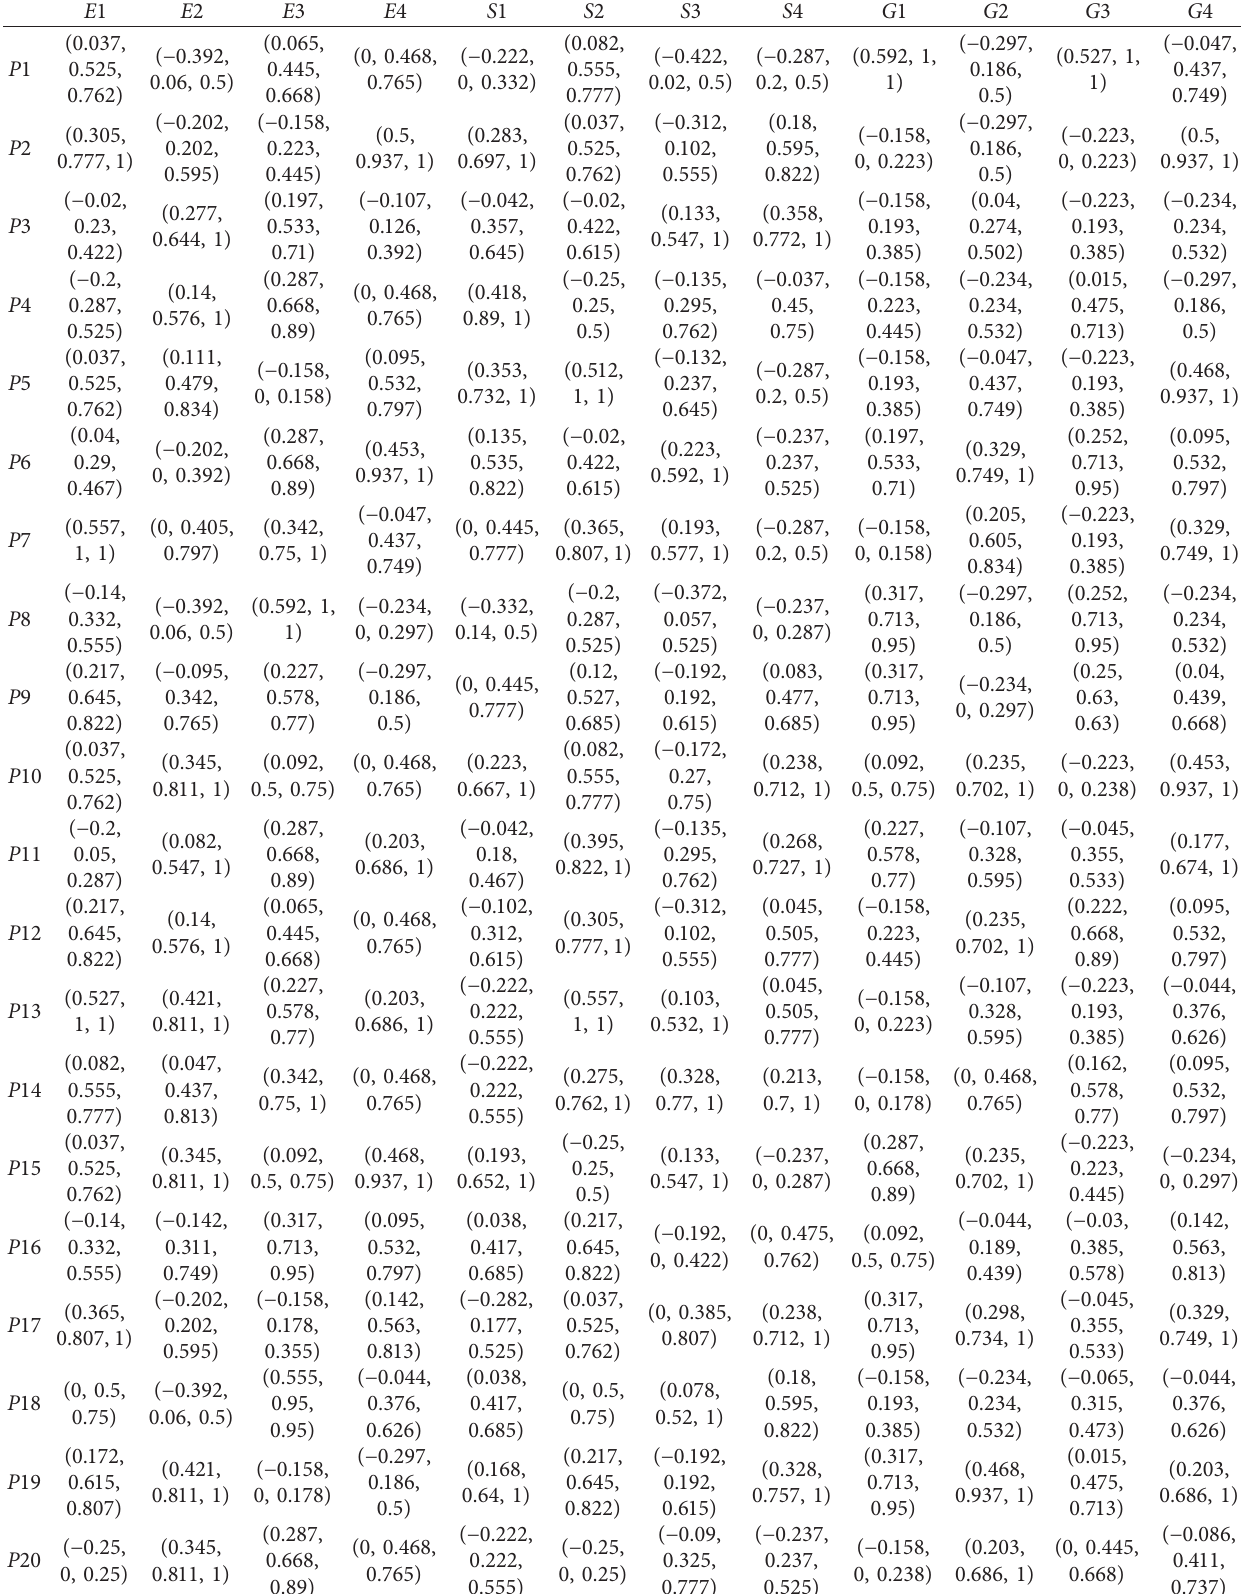
Table 48: Normalized scoring